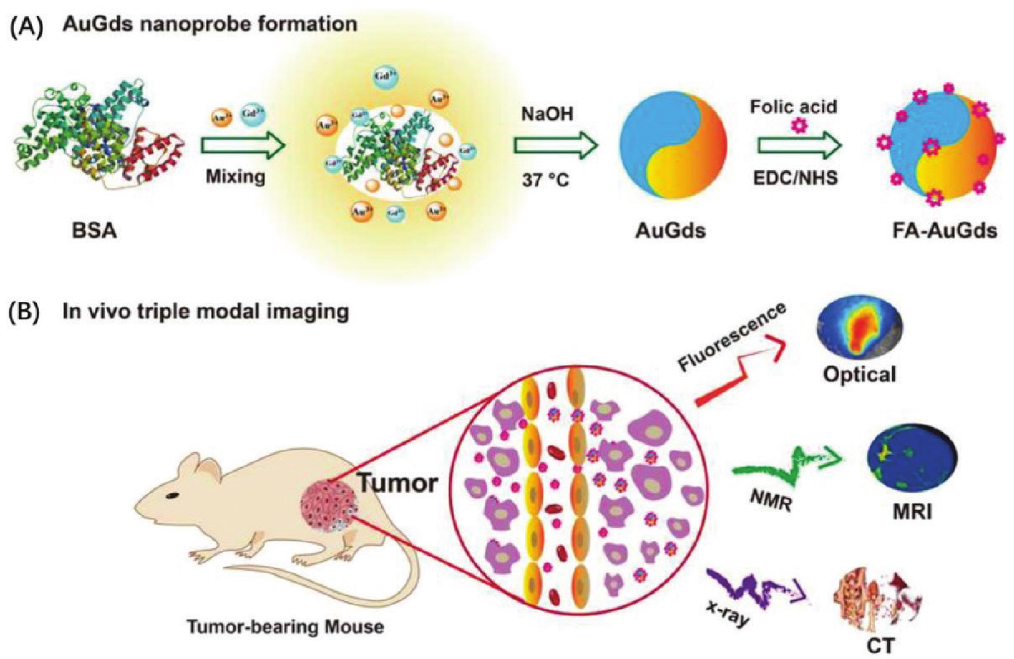
Figure 7: (a) Schematic diagram of Au Gds preparation; (b) Au Gds for trimodal tumor imaging. Reprinted image with permission from Ref. [80], Copyright 2011, WILEY-VCH Verlag GmbH &